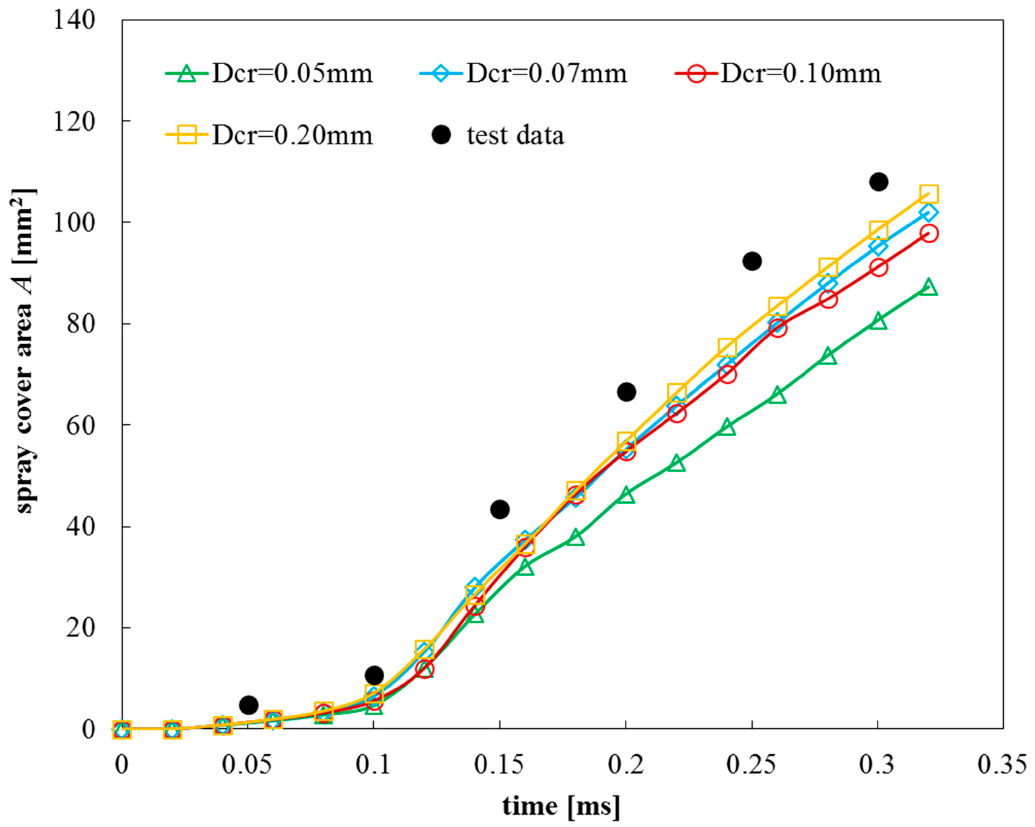
Figure 14. Spray